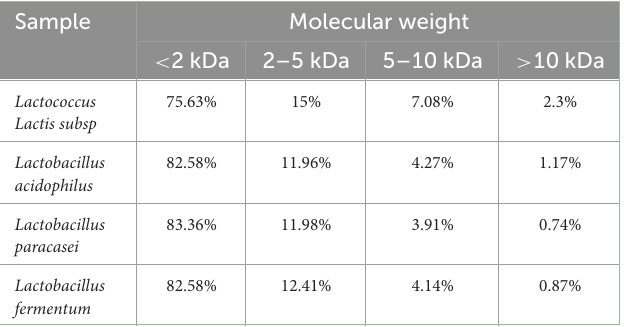
TABLE 2 Molecular weight distribution of quinoa polypeptides hydrolyzed by different bacterial taxa.